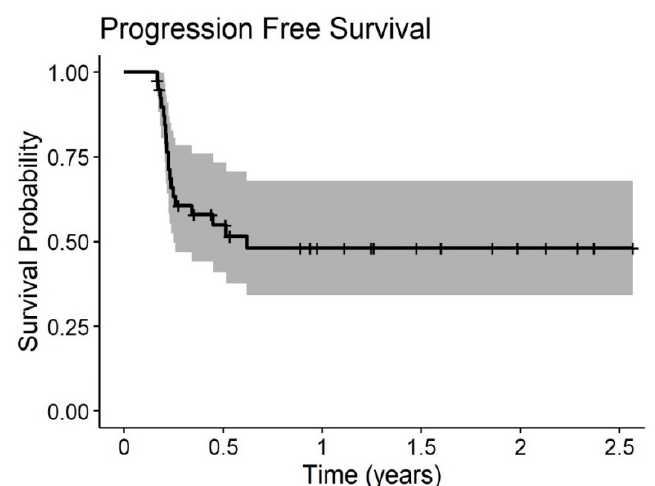
Figure 3. Progression-free survival of 20 patients with PC treated with at least two PIPAC procedures.